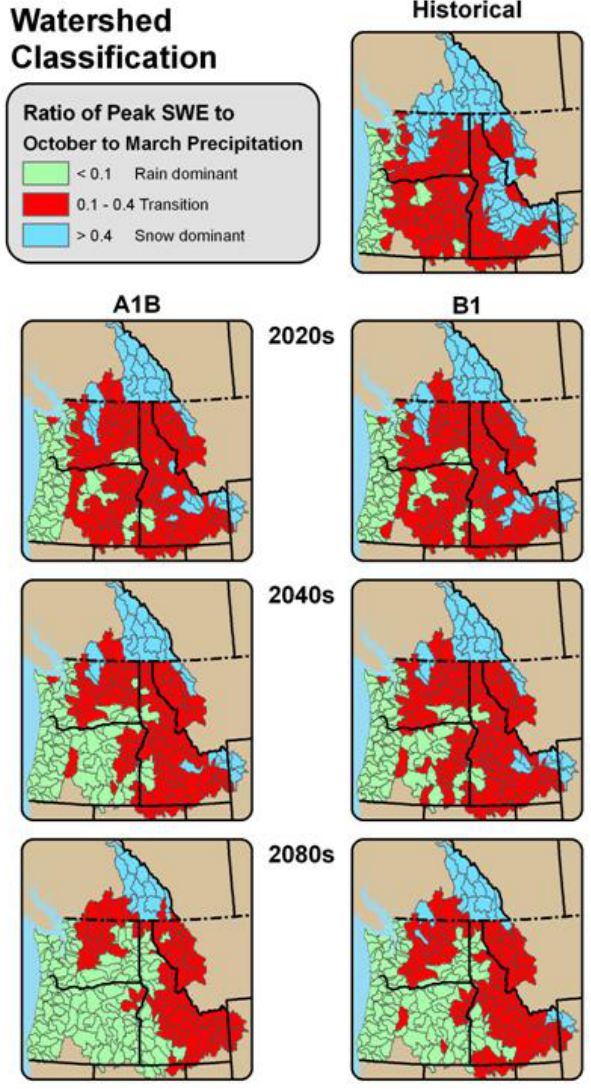
Figure 3. Simulated changes in the fraction of cool season precipitation stored as peak snow water equivalent (a measure of basin hydrologic response). Basins at the 8-digit (4th level) HUC scale are characterized as rain dominant ( < 0.1), mixed rain and snow (0.1 to 0.4), or snowmelt dominant ( > 0.4) for historical conditions and six composite delta method climate change scenarios. Source: Tohver and Hamlet